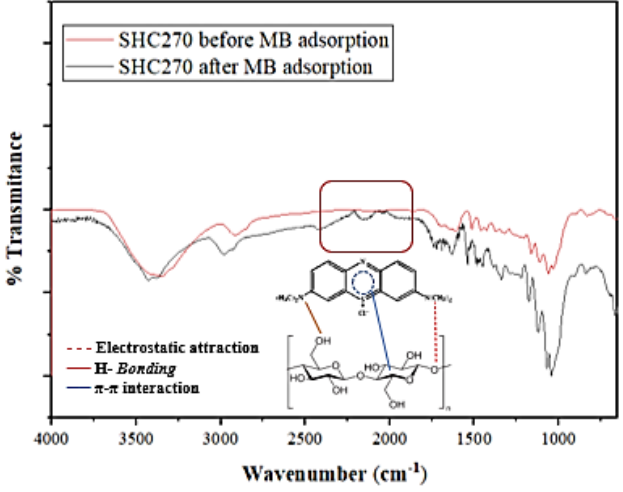
Fig 3. The Comparison of FTIR analysis between Hydrochar Adsorbent (SHC270) before and after Methylene Blue